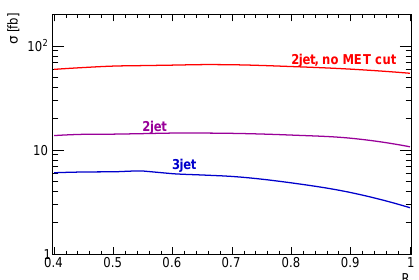
Figure 5: Dependence of the ( Z → j j ) H rate on R with the basic cuts of